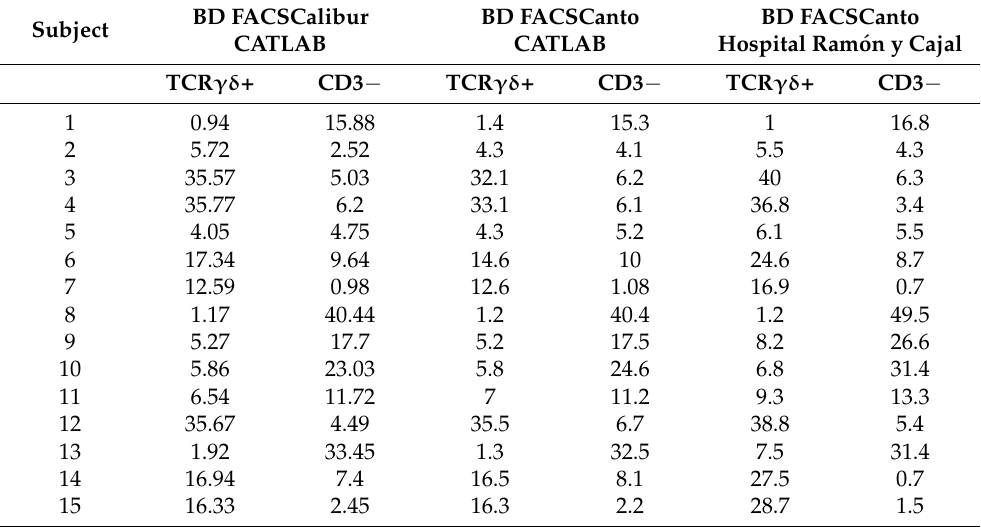
Table A1. Intraepithelial lymphocyte subpopulation data obtained using two different flow cytome- ters by one participating centre (CATLAB) and by the reference centre (Hospital Ram ó n y Cajal). Percentages are shown (over the total of CD45+ CD103+